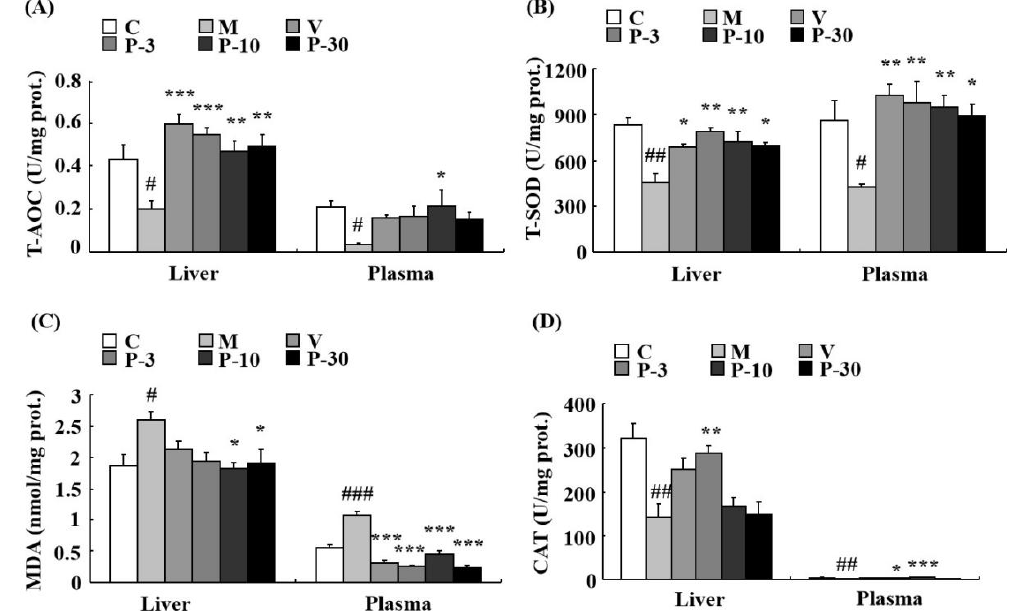
Figure 8. PAE decreased the oxidative stress in the liver and plasma. ( A ) Changes in total antioxidant capacity (T-AOC), ( B ) total superoxide dismutase (T-SOD) activity, ( C ) malondialdehyde (MDA) level, and ( D ) catalase (CAT) activity in the liver and plasma. Each value represents the mean ± SEM of 6 mice. # p < 0.05, ## p < 0.01 and ### p < 0.001 indicate significant di ff erence compared with the control group; * p < 0.05, ** p < 0.01, and *** p < 0.001 indicate significant di ff erence compared with the d -gal-treated group. C, control group, C received saline; M, d -gal model group, M received 150 mg / kg d -gal; V, 100 mg / kg VE group, it received 100 mg / kg VE + 150 mg / kg d -gal; P-3, 3 mg / kg PAE group, it received 3 mg / kg PAE + 150 mg / kg d -gal; P-10, 10 mg / kg PAE group, it received 10 mg / kg PAE + 150 mg / kg d -gal; P-30, 30 mg / kg PAE group, it received 30 mg / kg PAE + 150 mg / kg d